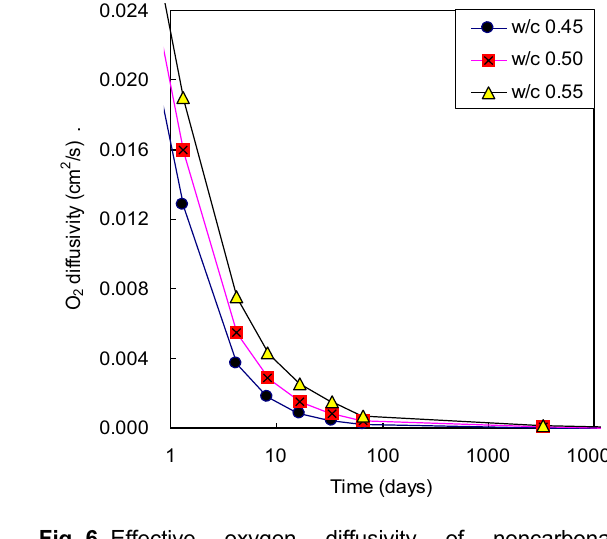
Fig. 5 Apprent oxygen diffusivity of noncarbonated concrete calculated with apparent pore.